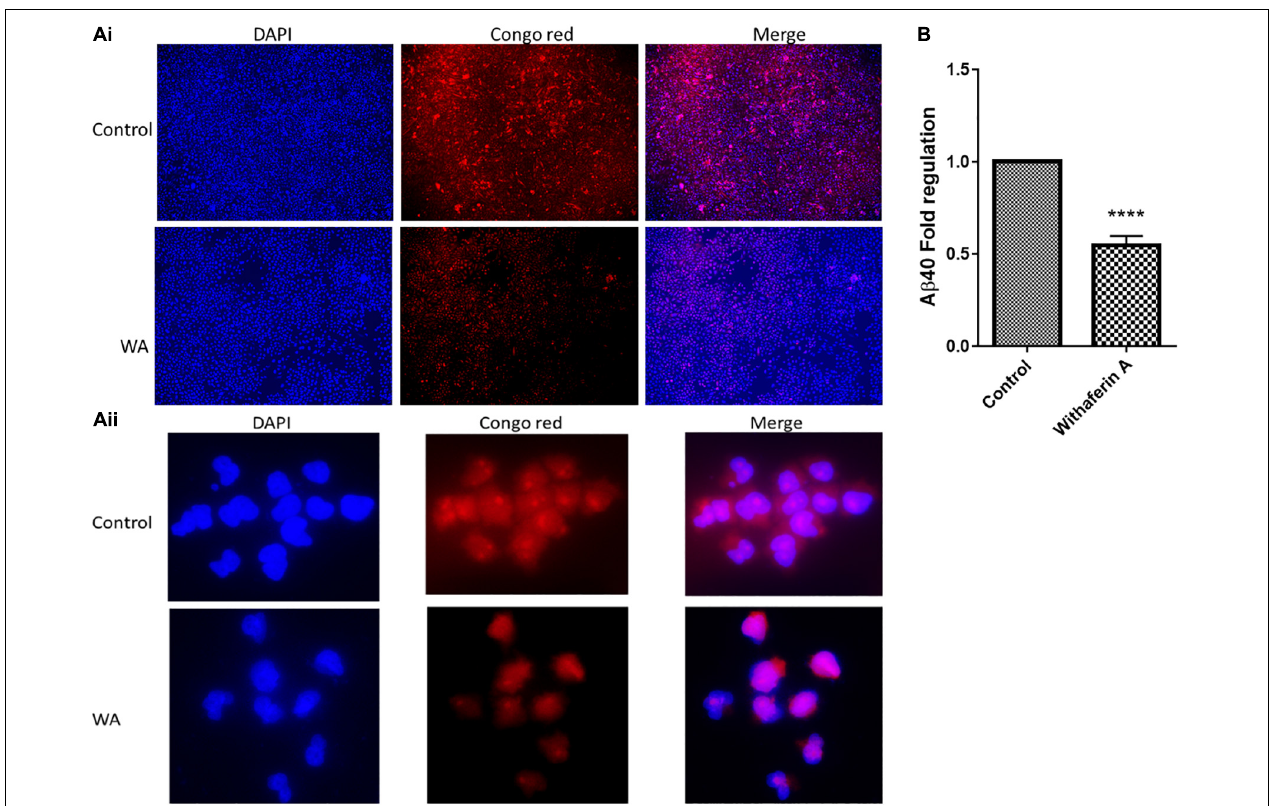
FIGURE 2 | Congo red staining and amyloid-beta (A β 40) ELISA for A β measurement: (Ai,ii) SH-APP cells were treated with 1 µ M concentration of withaferin A and incubated for 48 h. Cells were stained with the Congo red stain. We have observed significantly reduced levels of amyloid-beta expression in WA-treated cells when compared to the DMSO-treated control cells. (B) SH-APP cells were cultured in six-well culture plates and after 48 h of incubation, cells were treated with withaferin A (1 µ M). After 48 h of incubation, cell culture supernatant was analyzed for A β levels using A β 40 ELISA and observed a significant reduction of A β 40 levels upon WA treatment when compared to the DMSO-treated cells ( ∗∗∗∗ p ≤